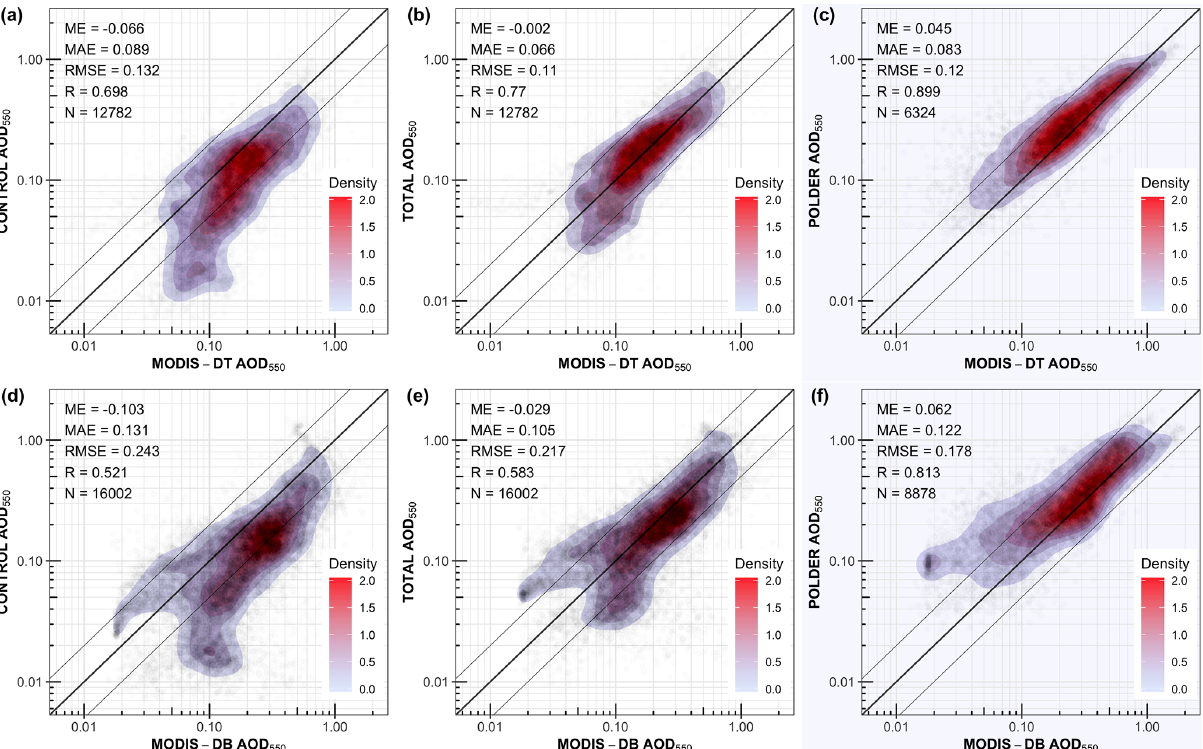
Figure 17. The AOD 550 of MODIS-DT over land against the CONTROL, TOTAL and POLDER experiments (a–c) . Similar setup for MODIS-DB AOD 550 (d–f) .